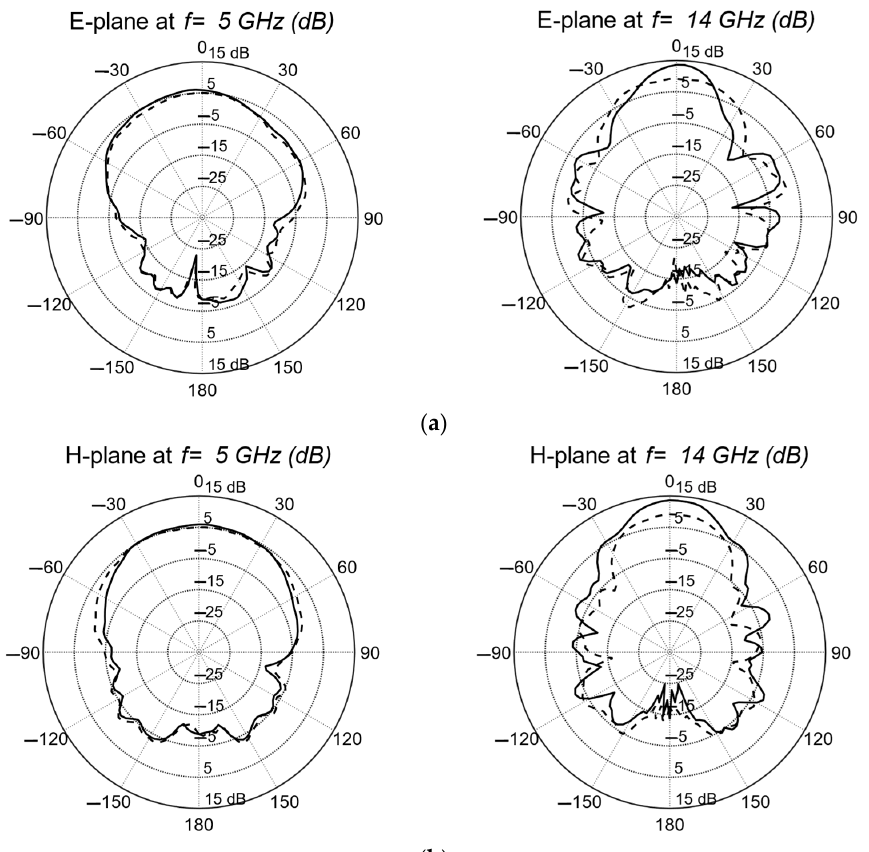
Figure 16. Measured ( a ) E-plane and ( b ) H-plane radiation patterns of AVA L-shaped#1 (solid curve) and AVA (dashed curve) at frequencies of f 1 = 5 GHz and f 2 = 14